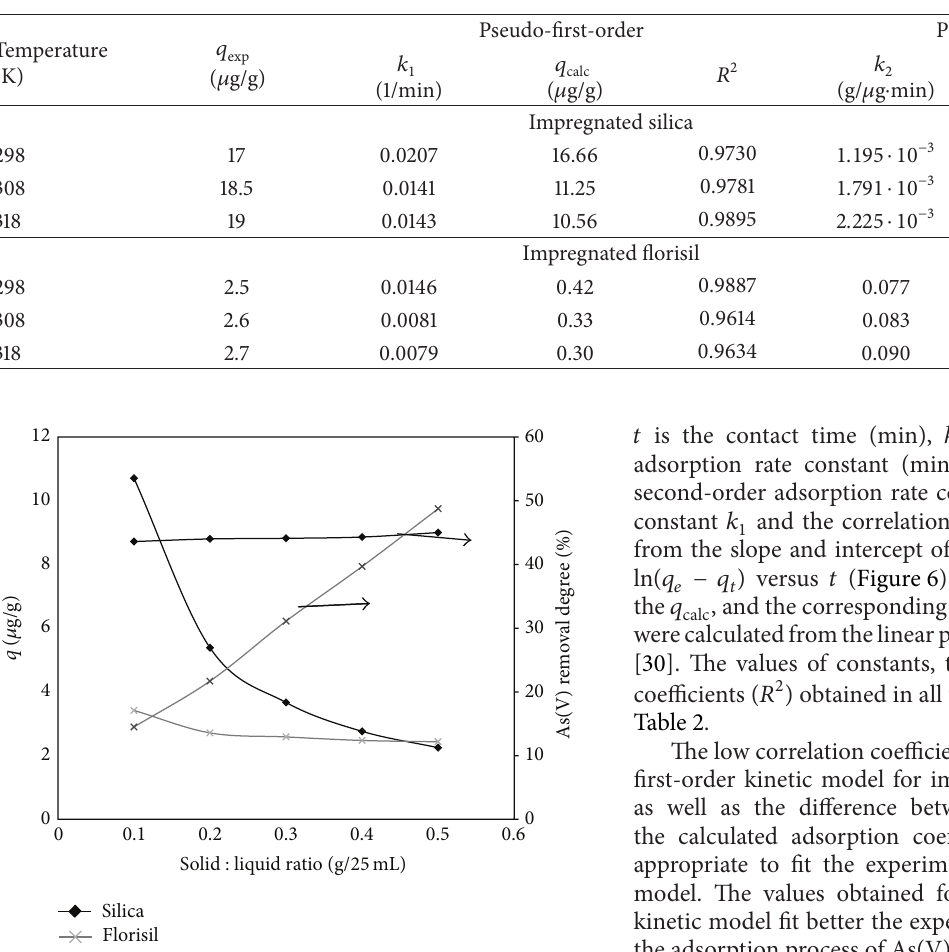
Table 2: Kinetic parameters for As(V) adsorption onto studied material.